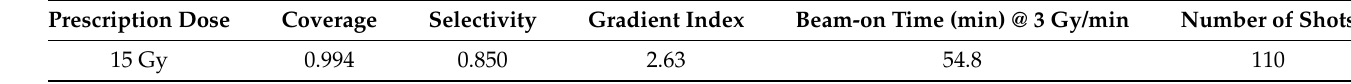
Table 1. Metrics for the medulloblastoma